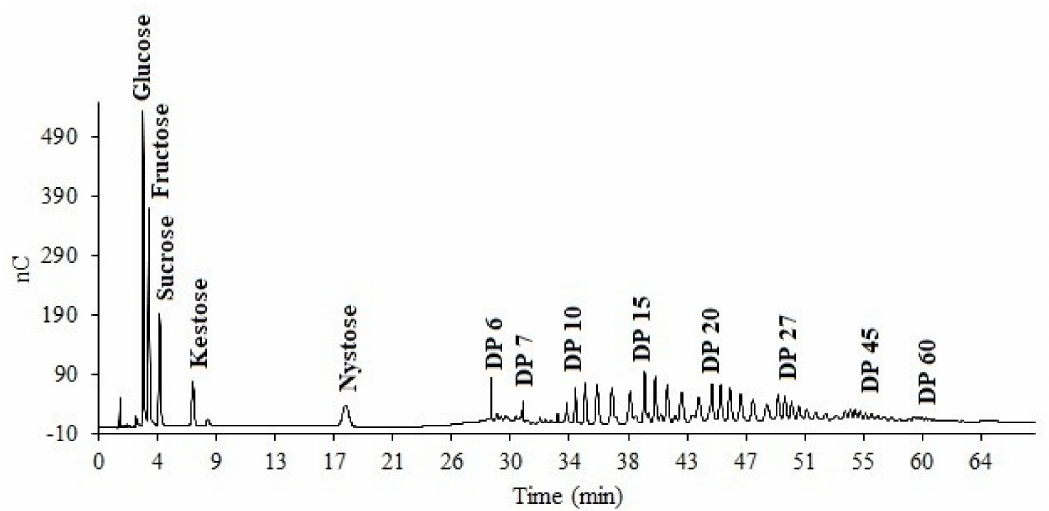
Figure 3. HPAEC-PAD of chicory inulin standard for the apparent Degree of Polymerization determination of Agave fructans.